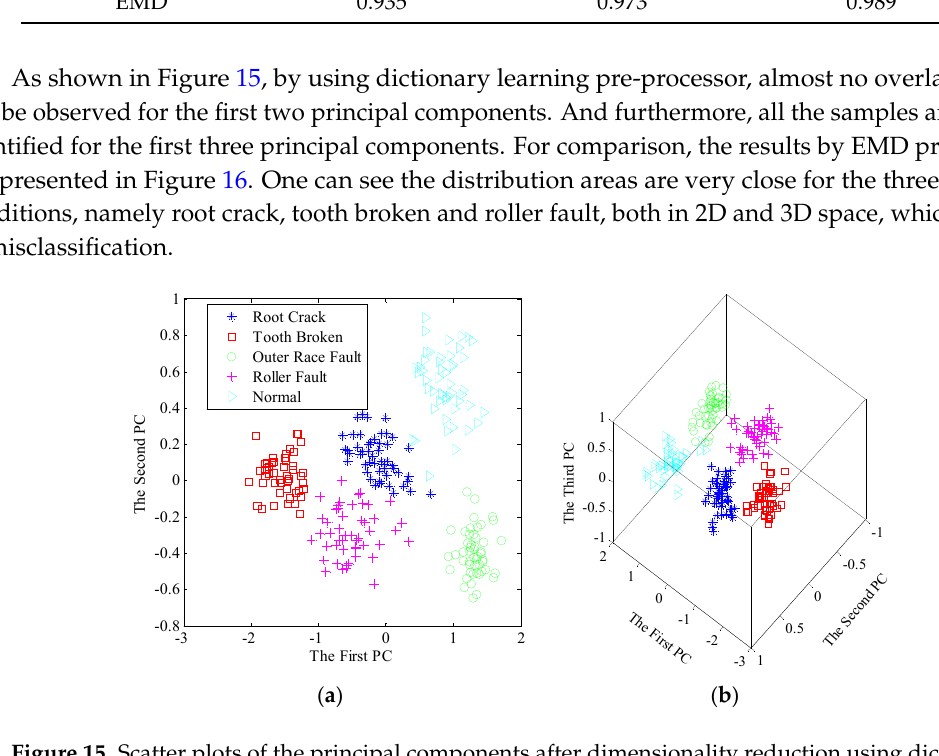
Figure 15. Scatter plots of the principal components after dimensionality reduction using dictionary learning and SVD: ( a ) The first two principal components; ( b ) The first three principal components.